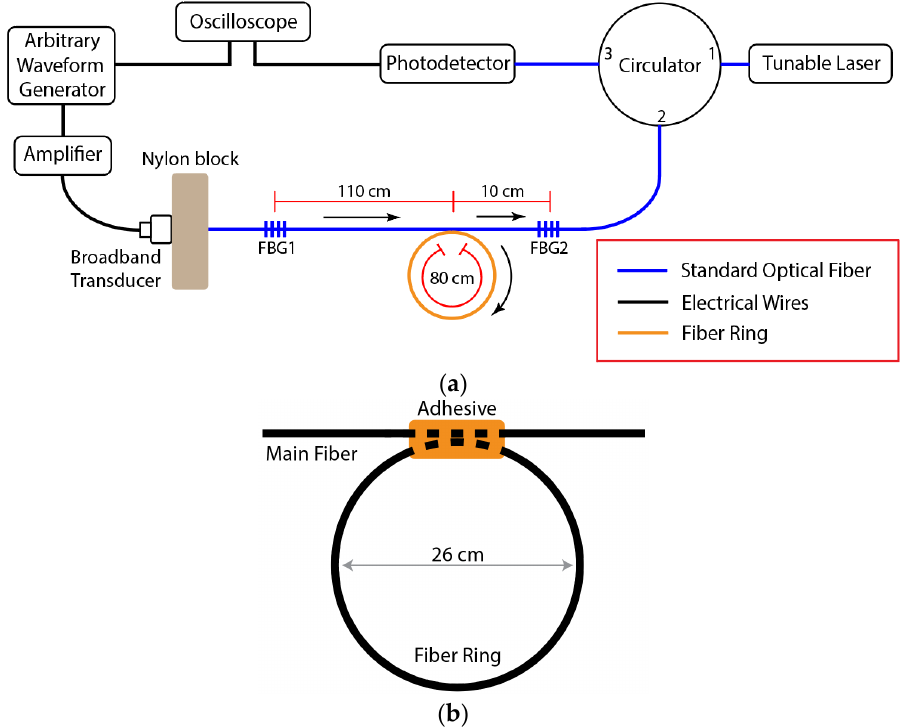
Figure 2. ( a ) Setup of the fiber-ring resonator experiment, with the acoustic wave paths shown as arrows. ( b ) Sketch of the fiber ring, attached to the main fiber using adhesive. arrows. ( b ) Sketch of the fiber ring, attached to the main fiber using